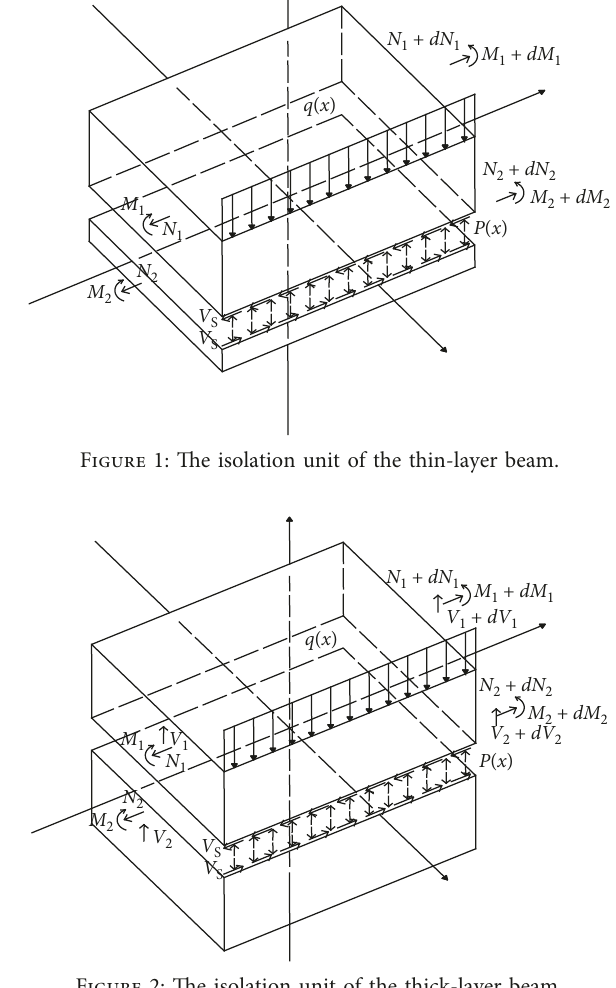
Figure 2: The isolation unit of the thick-layer beam.